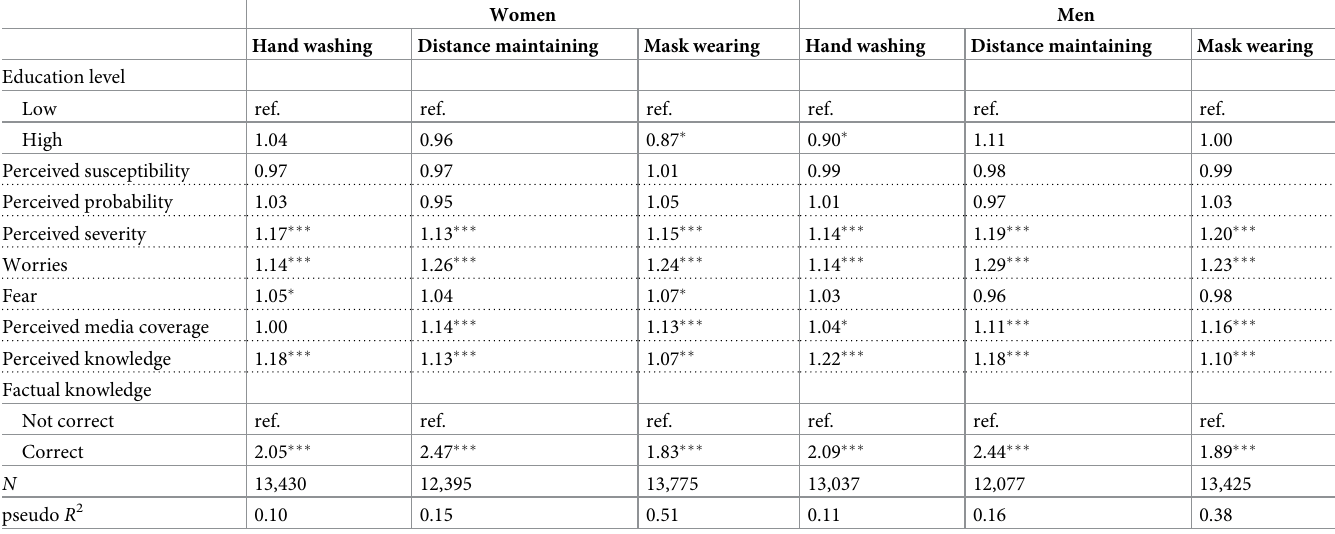
Table 3. Protective behaviours in women and men. Association with education level, risk perception and